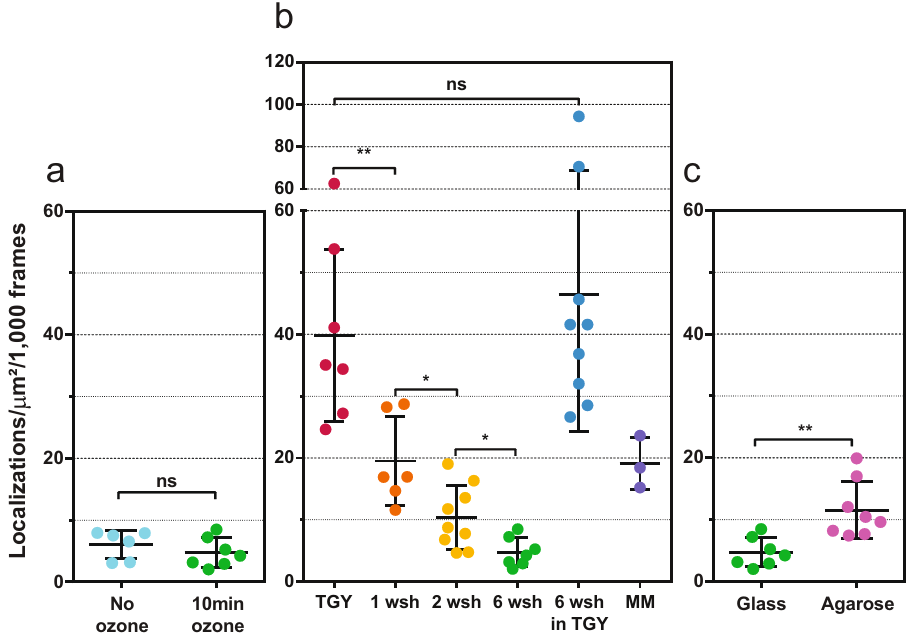
Figure 5. Comparative study of the autoblinking levels in fixed, unlabeled D. radiodurans cells. ( a ) Effect of ozone treatment of glass coverslides on the number of localizations in cells per µ m 2 per 1000 frames. ( b ) Effect of TGY growth medium and washes with highly pure PBS prior to sample mounting on the number of localizations in cells per µ m 2 per 1000 frames. TGY grown cells were either deposited directly between coverslides (TGY) or were washed once (1 wsh), twice (2 wsh) or 6 times (6 wsh) prior to imaging. A sample of cells washed 6 times with PBS was also resuspended again in TGY medium (6 wsh in TGY) before imaging. Cells initially grown in TGY and then transferred to minimal medium (MM) for 24 hours were also imaged. ( c ) Effect of the agarose pad on the number of localizations in cells per µ m 2 per 1000 frames. All images were acquired with a 50 ms frametime under continuous 0.8 kW/cm 2 561 nm laser. Individual data points correspond to the autoblinking levels derived from a given stack of images. Means and standard deviations are plotted in the